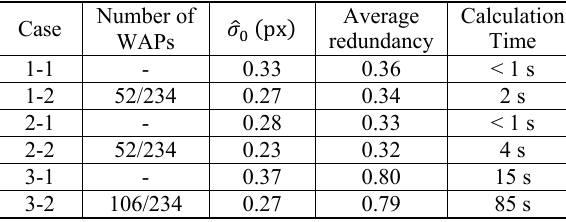
Table 3. The bundle block adjustment results of all test cases Figure 4 illustrates the average image distortion